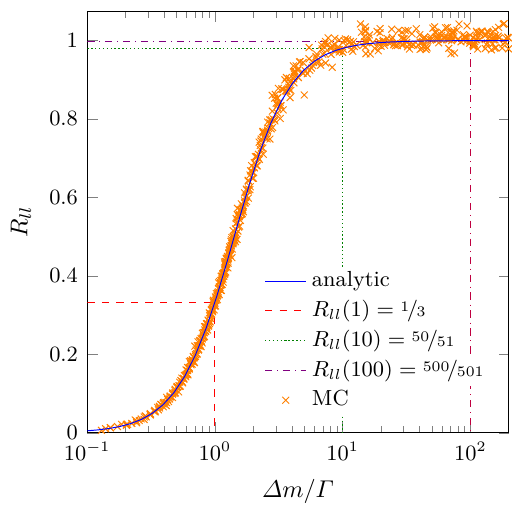
Figure 14 . Comparison between the analytic calculation ( 3 . 10 ) and simulated events for the LNV over LNC ratio R ll as a function of the ratio ∆ m/ Γ . The three indicated special cases for R ll (∆ m/ Γ) correspond to the oscillations shown in figure 4 .